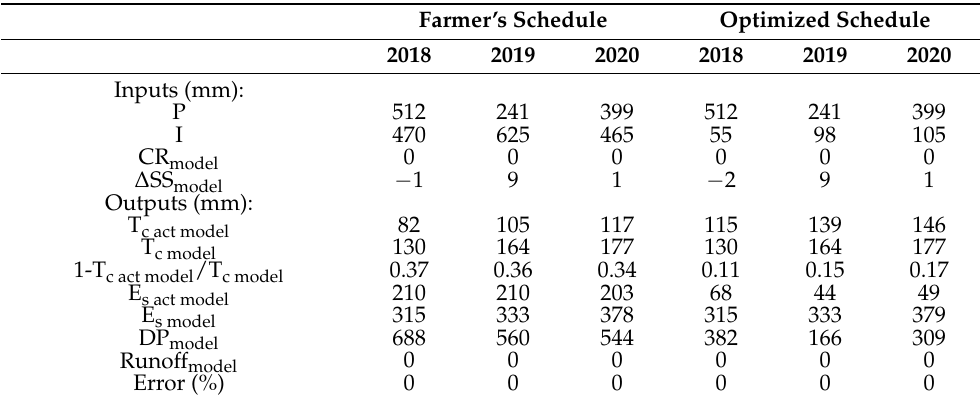
Table 4. Soil water balance in the studied